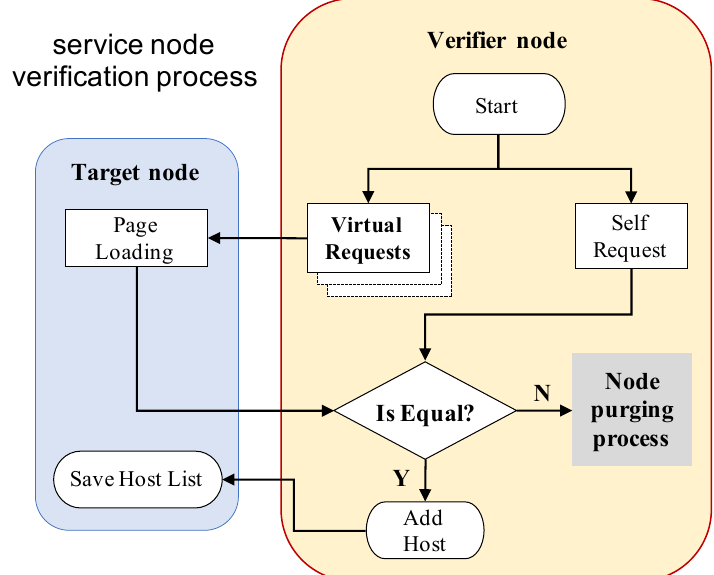
Figure 4. Service Node Verification